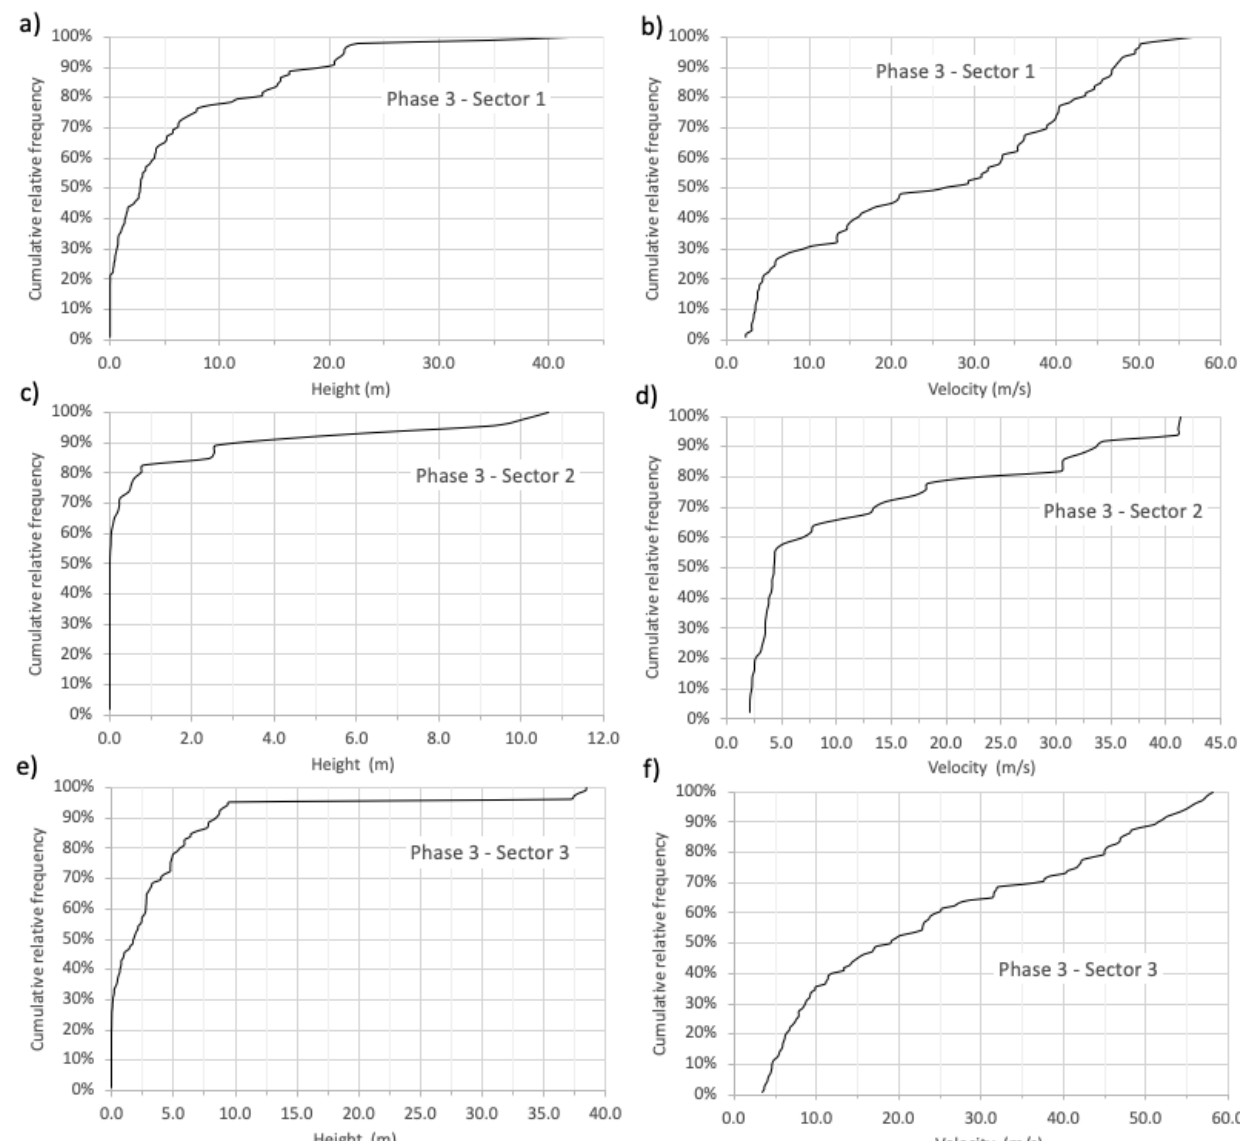
Figure 12. Cumulative relative frequency of heights ( left ) and velocities ( right ) for Phase 3 trajectories reaching Sector 1 ( a,b ), Sector 2 ( c,d ) and Sector 3 ( e,f ).